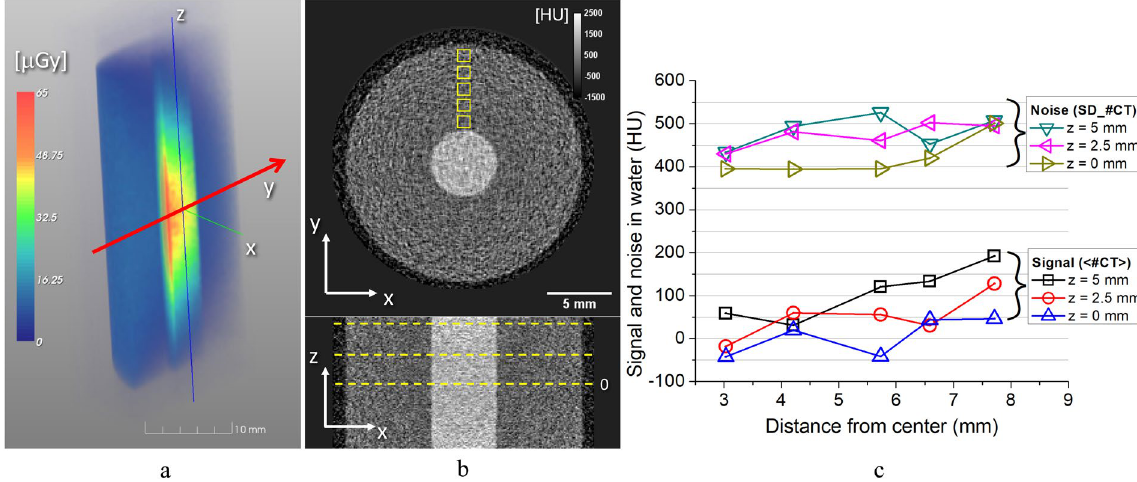
Figure 5. ( a ) Volume rendering of the 3D distribution of the X-ray dose delivered by a single laser shot to the water phantom with iodine insert (see text). For visualization purposes, a virtual cutting on the yz plane has been made on this rendering. The red arrow ( y axis) shows the main direction of propagation of the X-ray beam for the selected laser shot. ( b ) Transverse (top) and coronal (bottom) slices of the tomographic reconstruction of the same phantom in ( a ). All images are reconstructed with a SIRT algorithm, 300 iterations, and with an isotropic voxel of 100 μ m. ( c ) Average reconstructed values (signal) and noise in water at several radial and axial positions. The radial positions of the ROI’s are depicted as yellow squares in ( b ), whereas the axial positions are shown as dashed lines in the coronal image (only z = 0 is